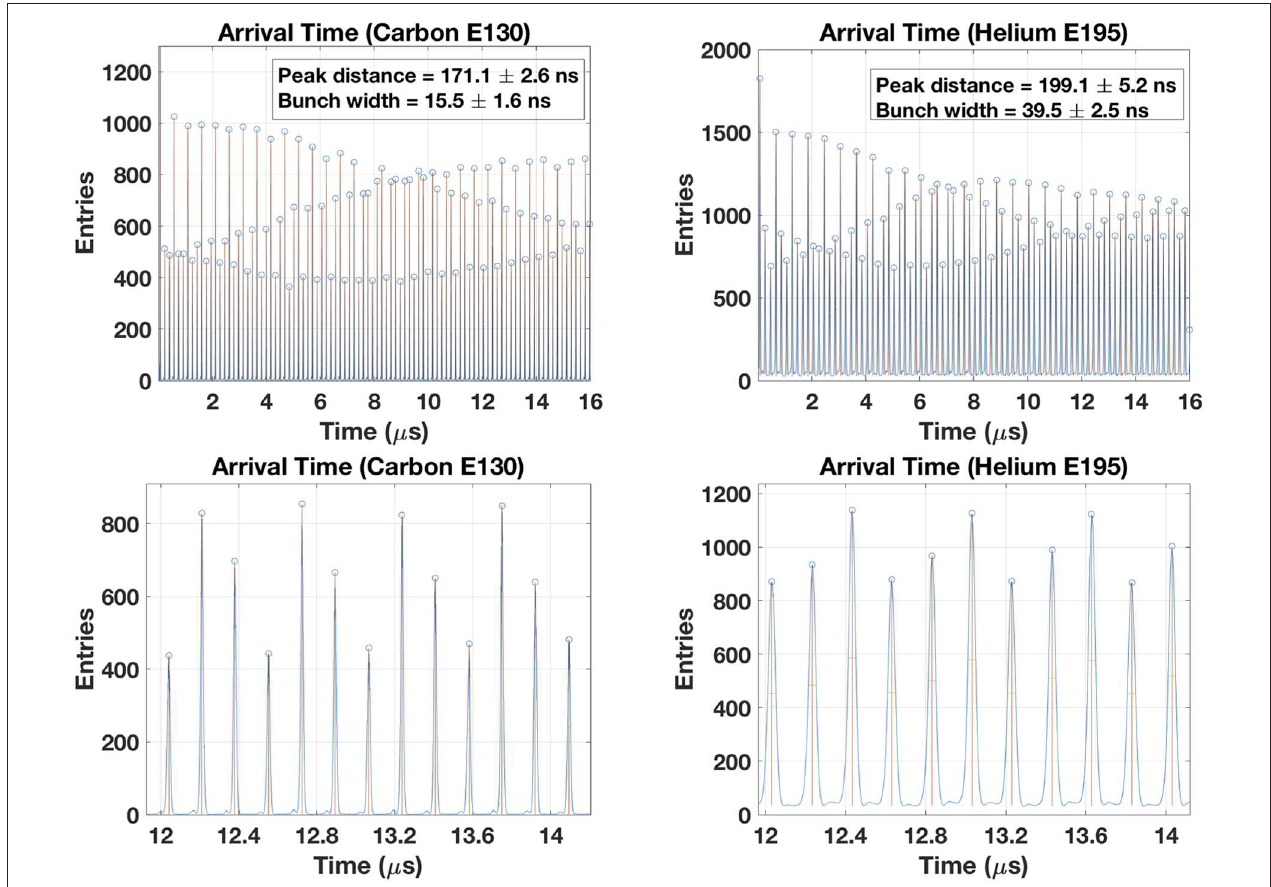
FIGURE 6 | Bunch width and peak interval of a carbon beam with 276 MeV/u (left) and a helium beam with 180 MeV/u (right) . A zoom over the region 12–14 µ s shows the bunch width (bottom) .